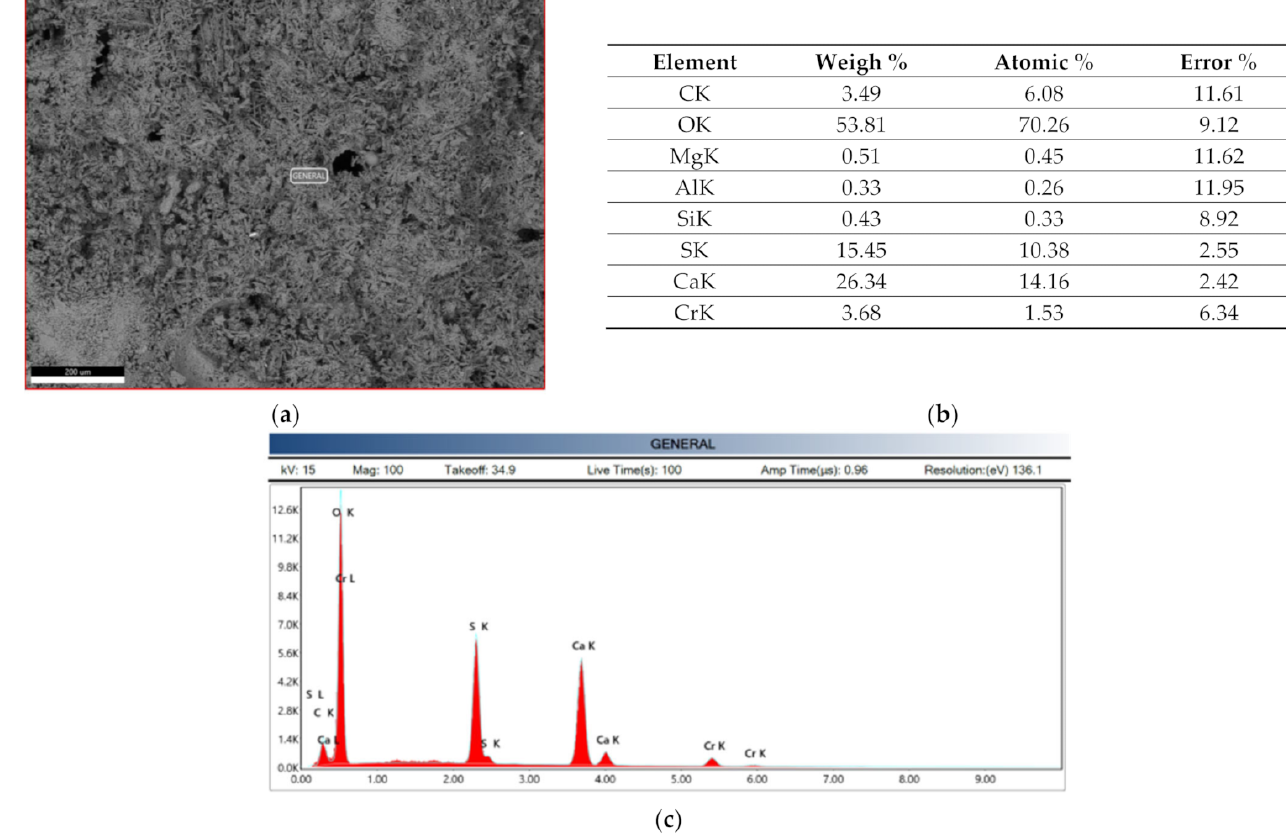
Figure 20. Analysis area and results for the melamine compound with calcium sulfate, showing the general sample area and X-ray spectrograph (source: the author): ( a ) micrograph of gypsum with melamine; ( b ) chemical composition; ( c ) chemical composition of gypsum with melamine.